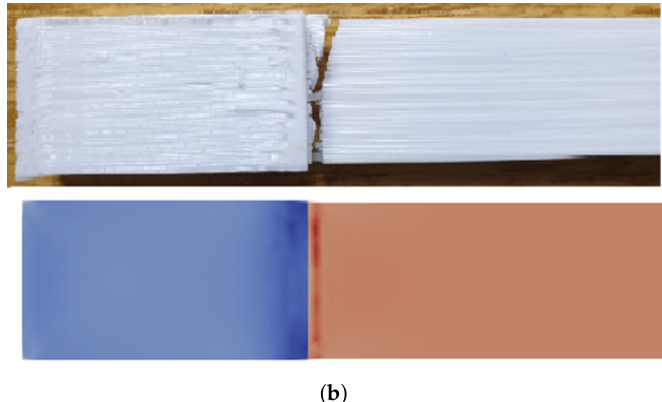
Figure 7. Experimental results (top) showing a brittle failure at a position directly related to the stress distribution verified by computations (bottom). ( a ) For the ISO-modified specimen. ( b ) For the ASTM D3039 specimen (zoom to the clamped end).